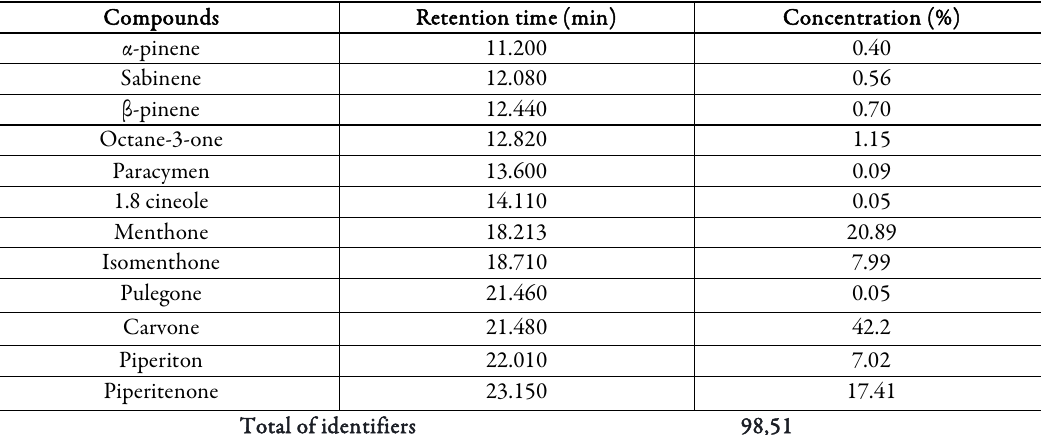
Table 1. Concentration in % and retention time of the different compounds obtained by gas chromatographic analysis of the essential oil of M. spicata Compounds Retention time